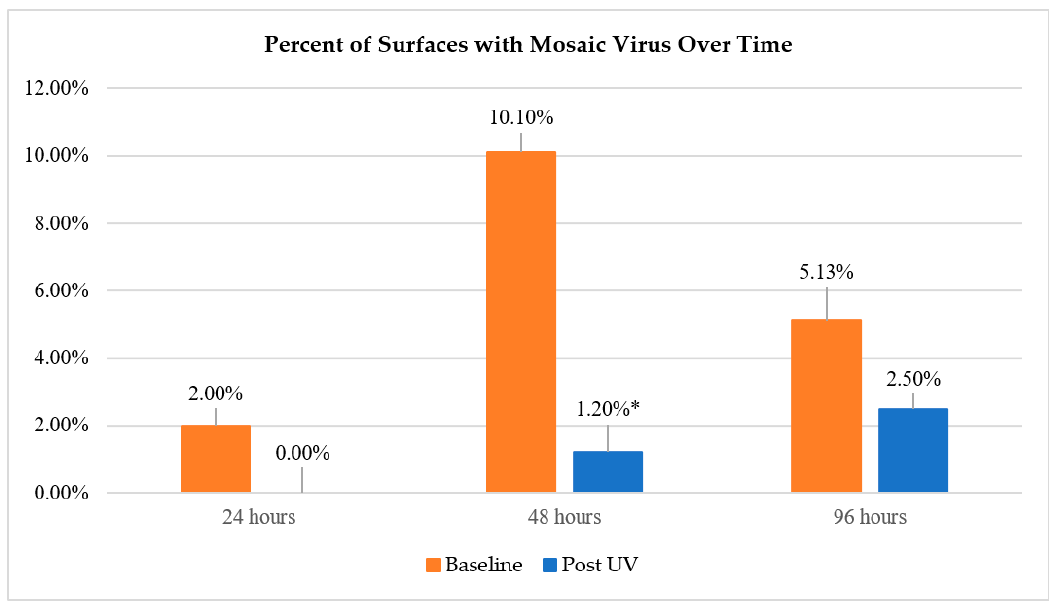
Figure 1. Percent of intensive care unit (ICU) Surfaces Contaminated with Mosaic Virus at Sequential Samplings. * Denotes a statistically significant reduction.